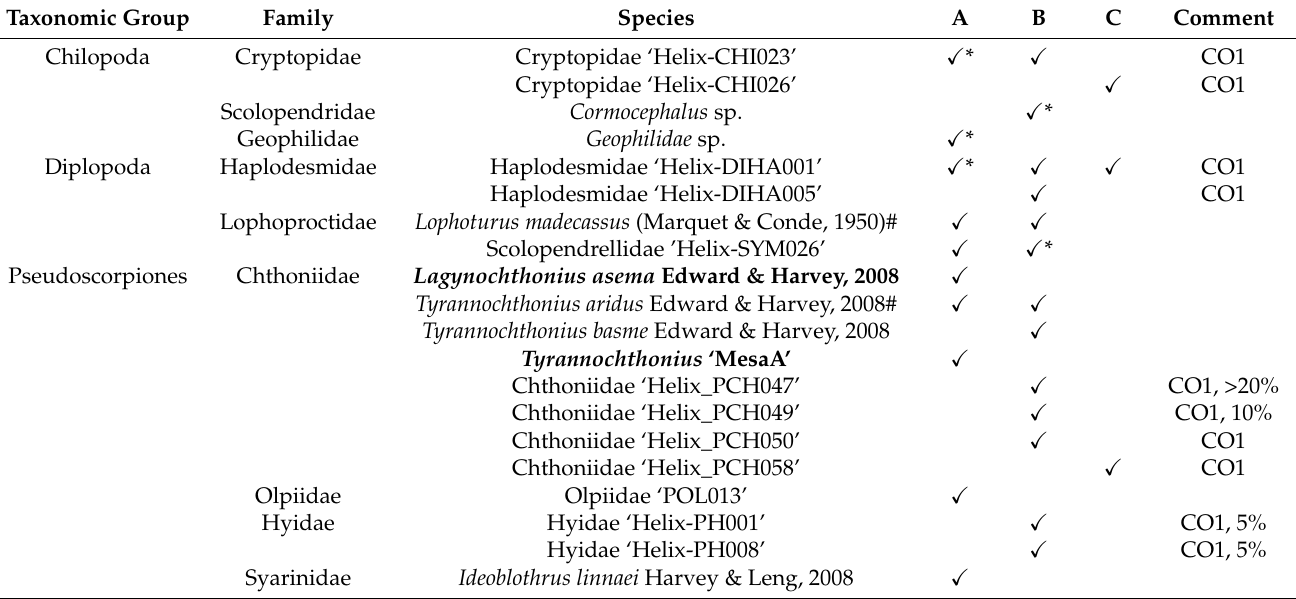
Table 1. Troglofauna species collected from Mesas A, B and C. Records with an asterisk represent identifications above species level, but they are usually aligned with a related species to reduce table size. Species in bold have special conservation protection. Comments show species delimited using CO1 results, with divergence values from other species indicated where available. # indicates species are troglophiles, whereas all other species are likely